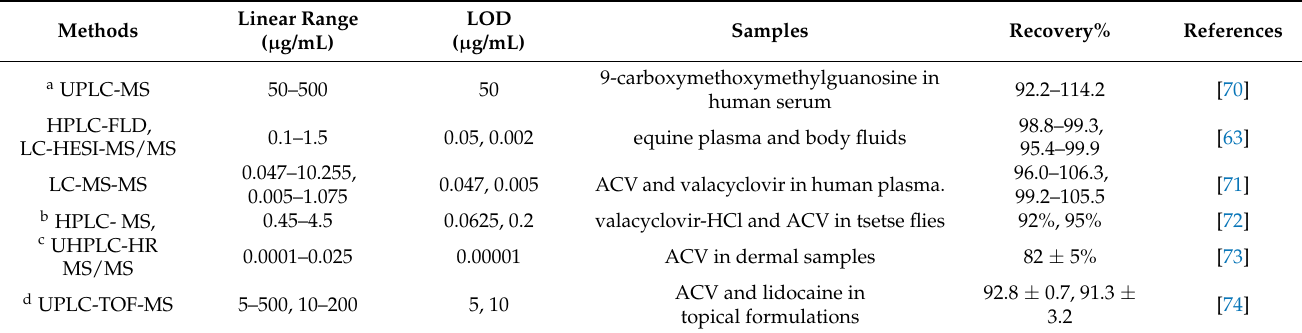
Table 8. Various LC-MS/MS methods for the detection of